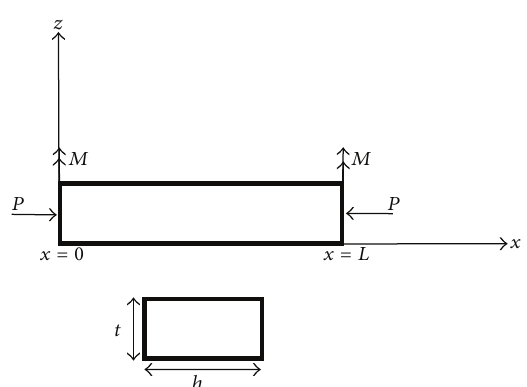
Figure 1: Beam with axial load and end moment applied at 𝑥 = 0 and 𝑥 = 𝐿